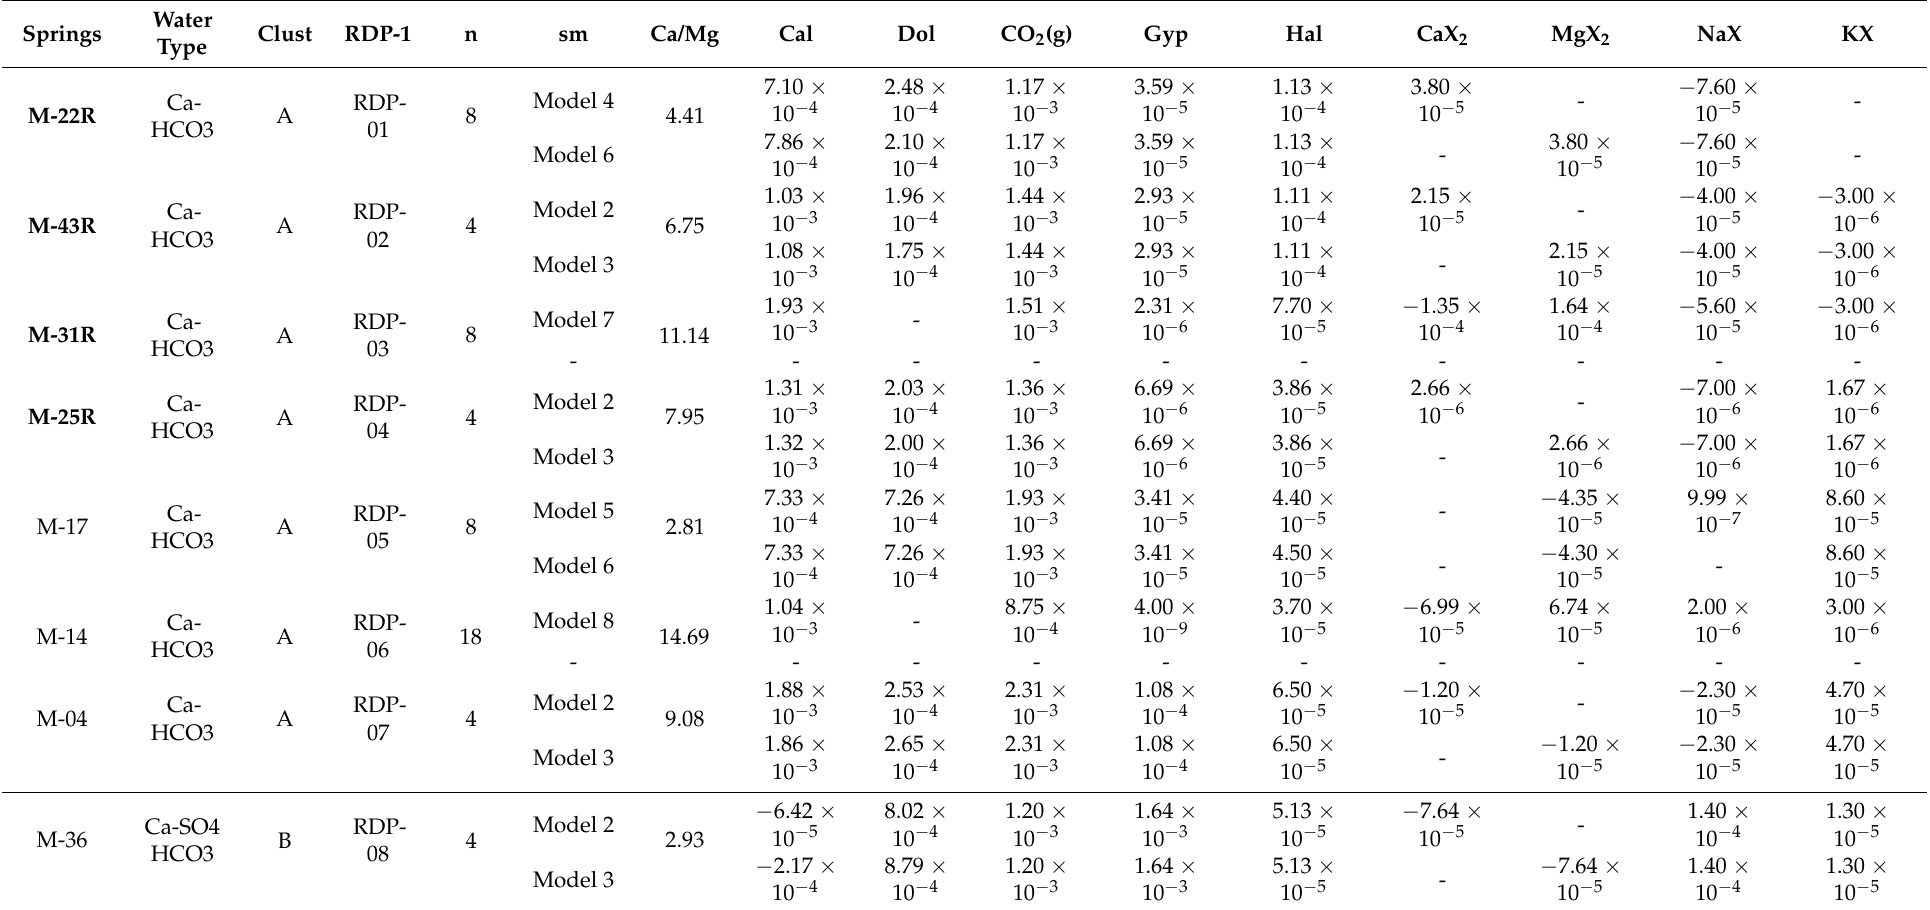
Table A9. Results of inverse geochemical reaction Recharge-Discharge Pathway Modelling using PHREEQC (Values in moles per kilogram. Positive values indicate dissolution and negative values indicate precipitation. Dashes indicate phase not used in model) (Clust—cluster; n—number of models; sm—selected models; Ca/Mg—molar ratios; Cal—Calcite; Do—Dolomite; Gyp—gypsum;